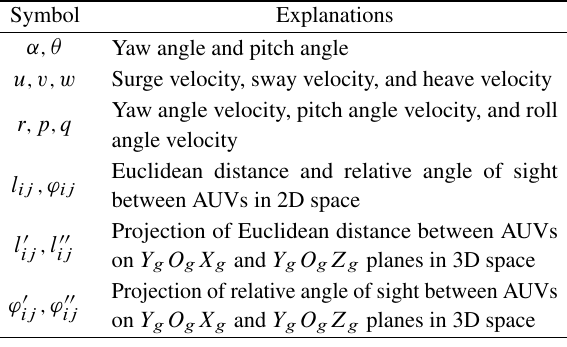
Table 2 Explanations of symbols in Figs. 3 and 4.